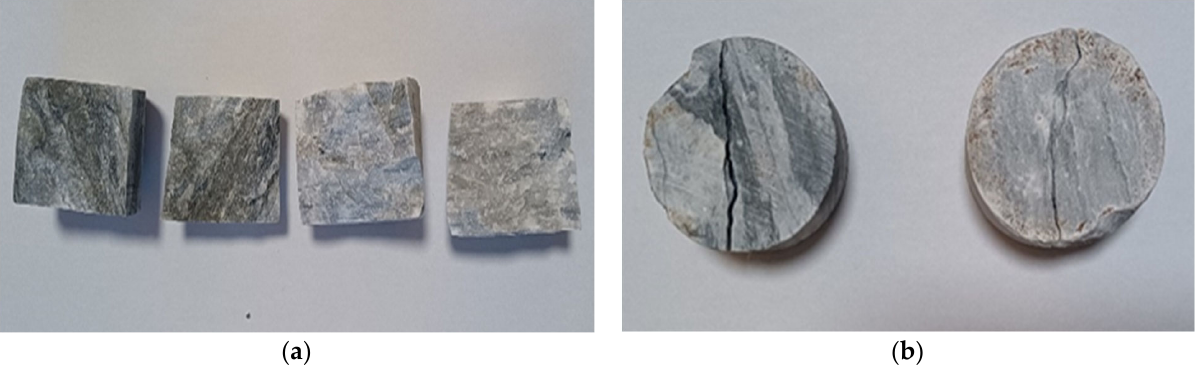
Figure 6. Schematic diagram of partially damaged specimens during SHPB commissioning. ( a ) Ex ‐ pansion diagram of test block failure; ( b ) Test block destruction diagram.